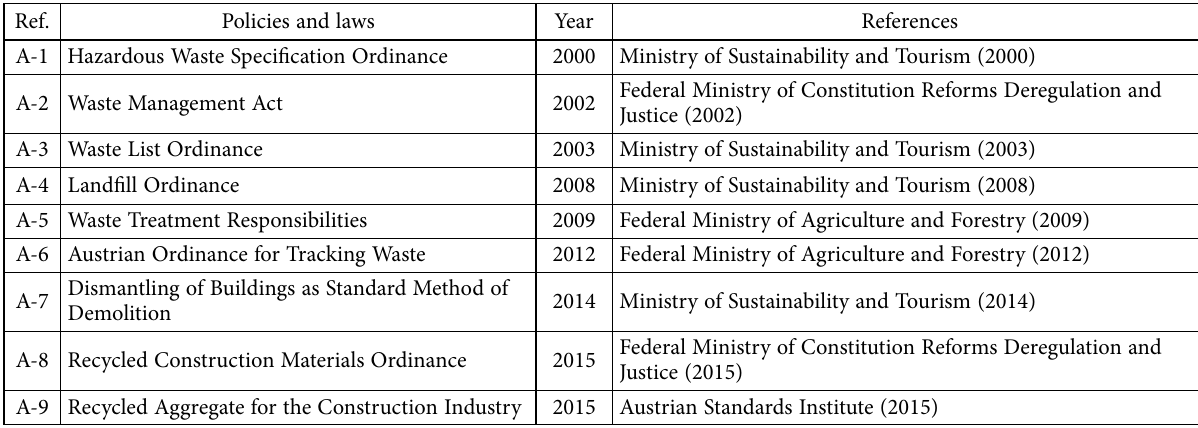
Table 8. Existing policies and laws on C&D waste management in Austria